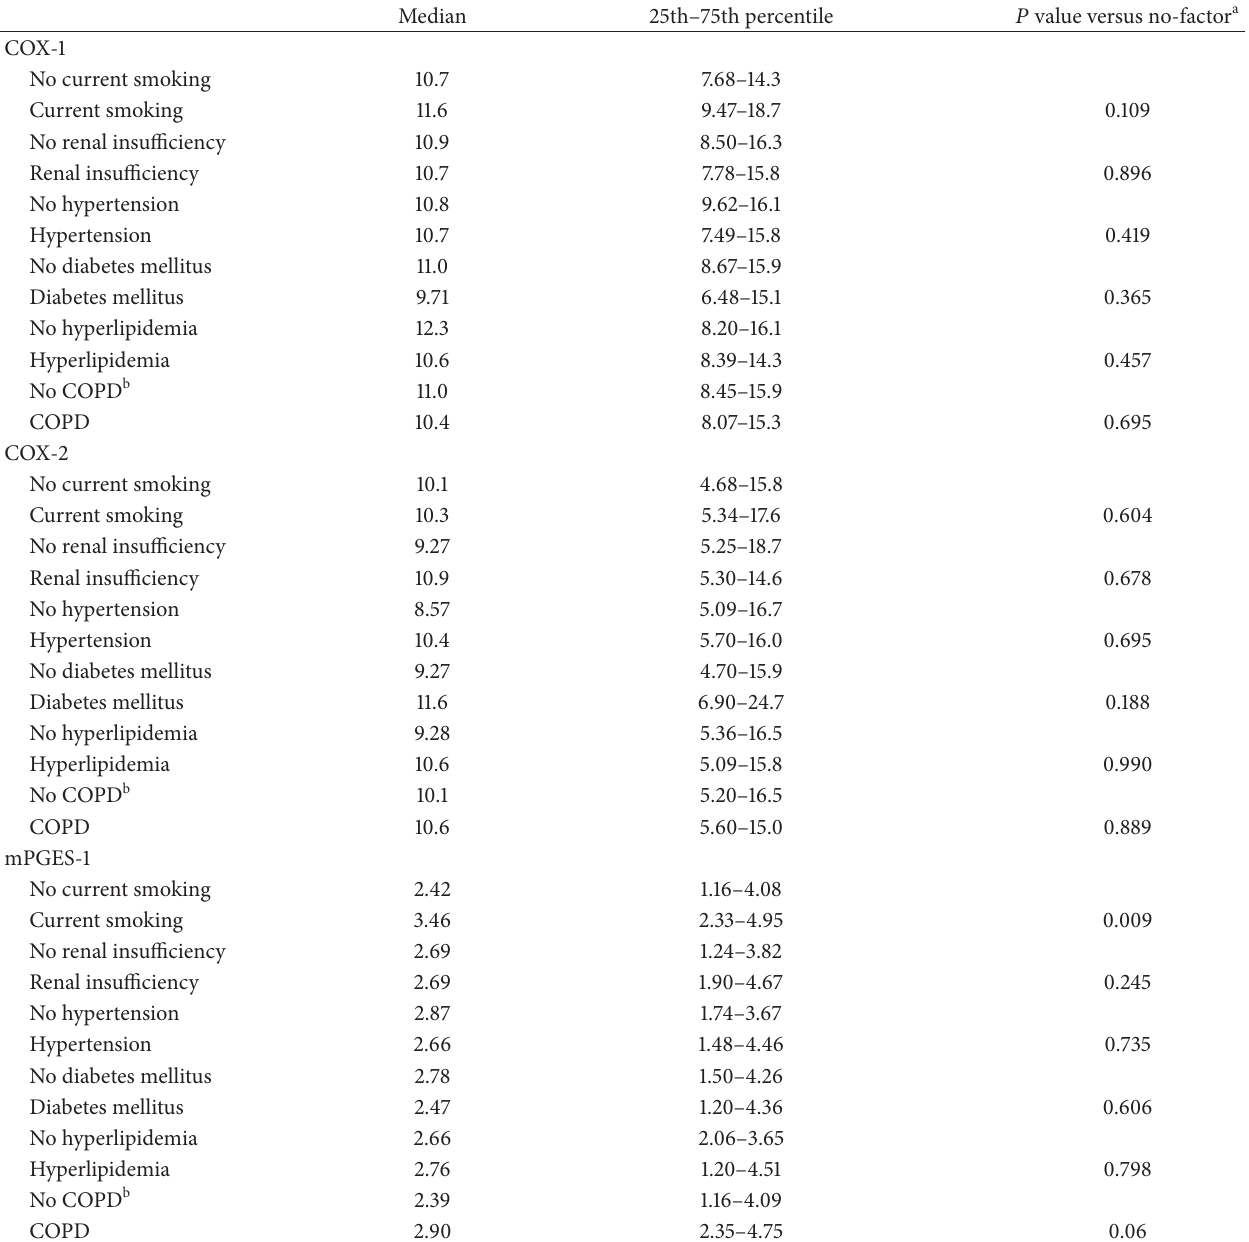
Table 2: Transcript levels of COX isoenzymes and mPGES-1 in the AAA samples stratified by cardiovascular risk factors. The number of patients in every group is indicated in Table 1. Data are expressed as relative to 𝛽 -actin